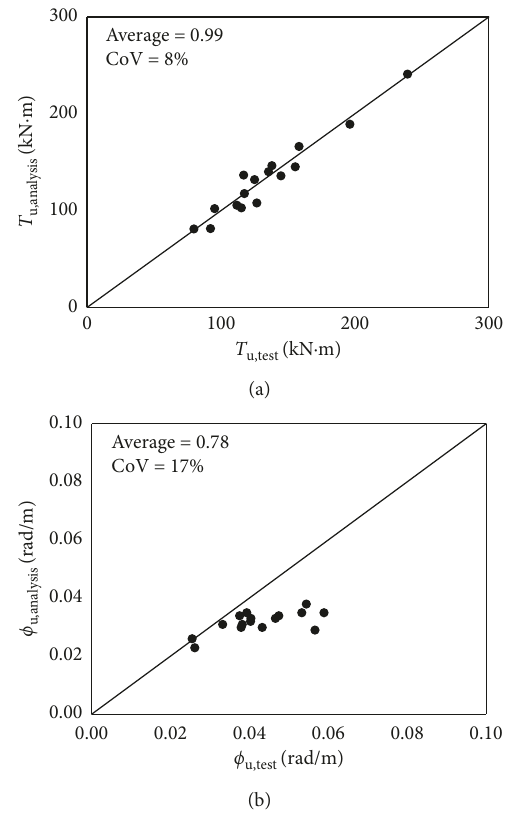
Figure 16: Analysis and test results comparison. (a) Torsional capacity. (b) Angle of